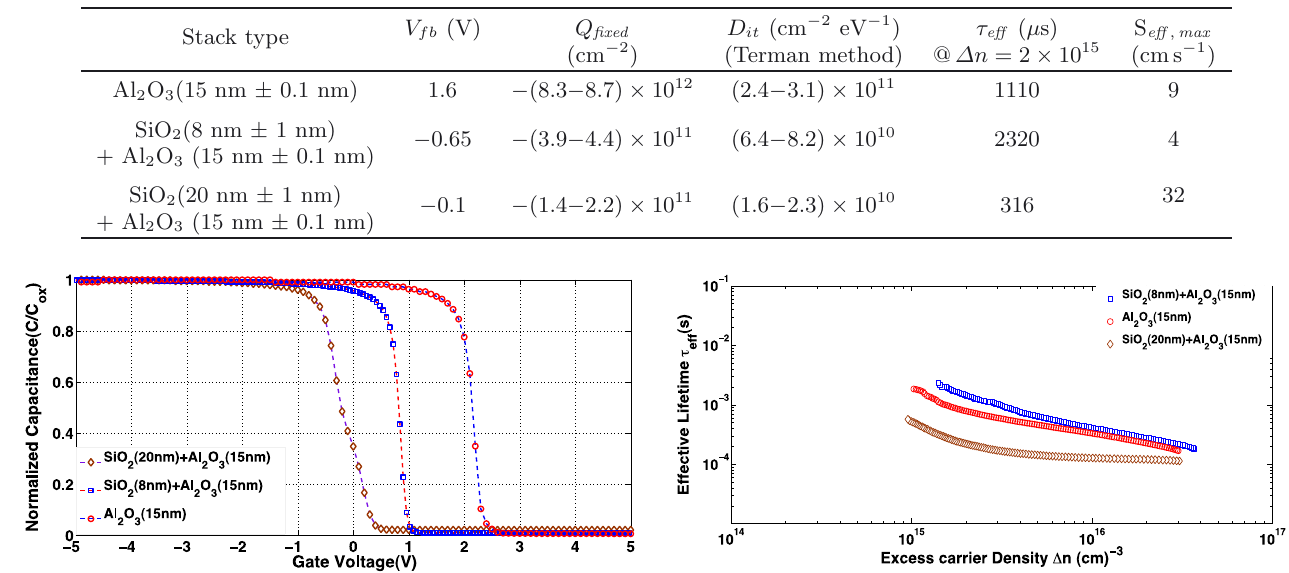
Fig. 6. C - V characteristics of SiO 2 /Al 2 O 3 stacks. Fig. 7. Lifetime measurements on SiO 2 /Al 2 O 3